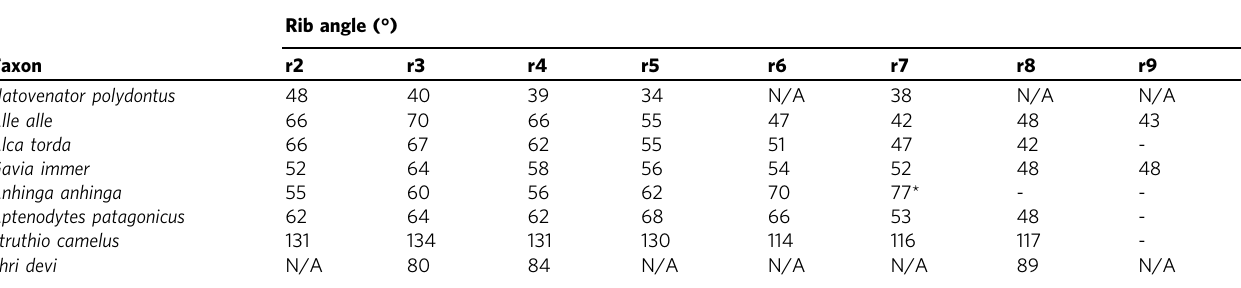
Table 1 Dorsal rib angles of Natovenator polydontus , various diving birds, and terrestrial taxa measured in ventral view. Rib angle